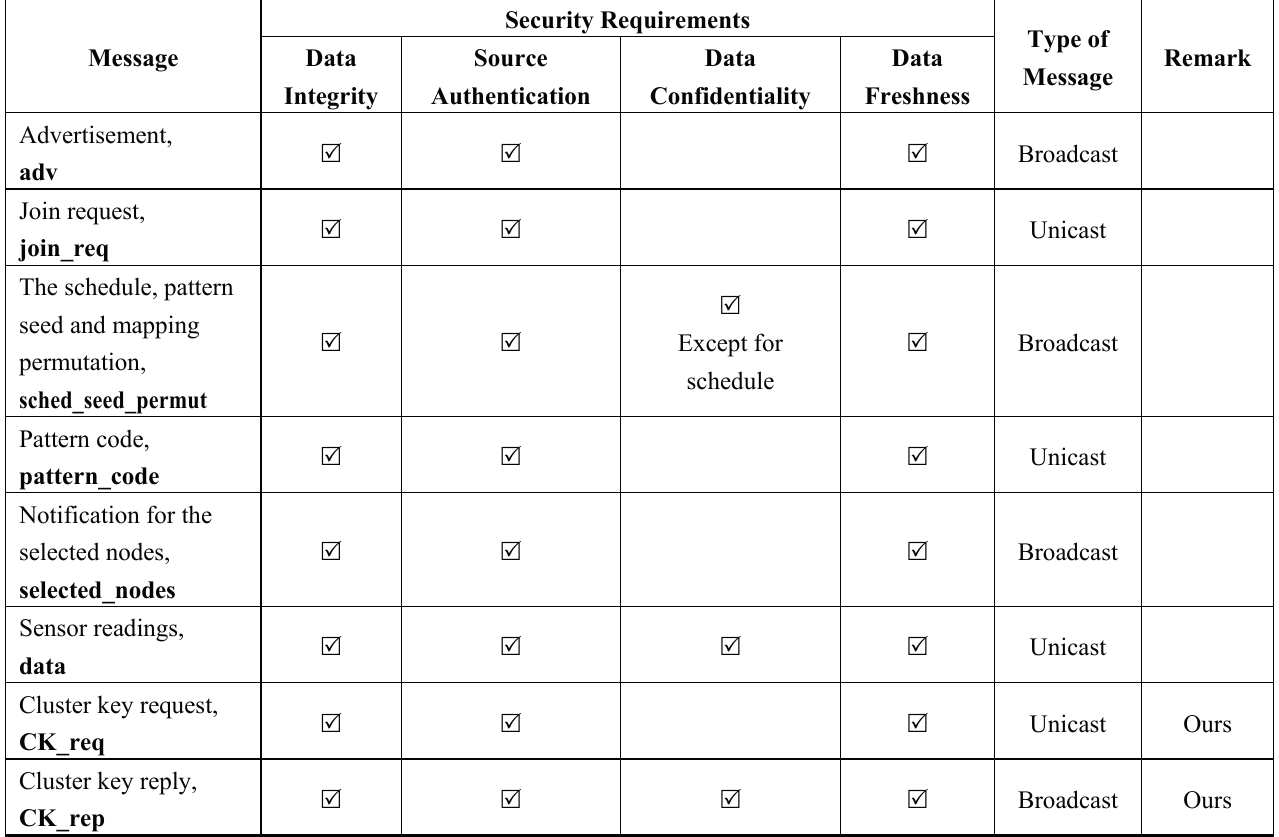
Table 1. Security requirements of the proposed